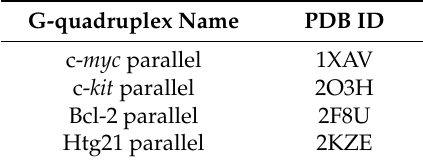
Table 7. G-quadruplex structures used in molecular docking. PDB: Protein Data Bank.